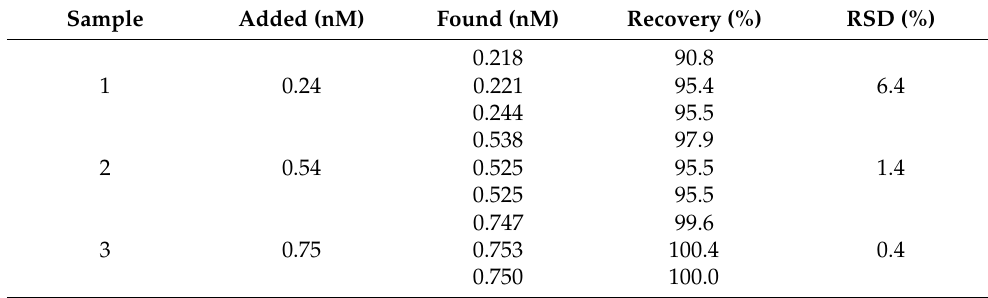
Table 1. Recovery of miRNA-21 in a spiked human serum sample ( n =